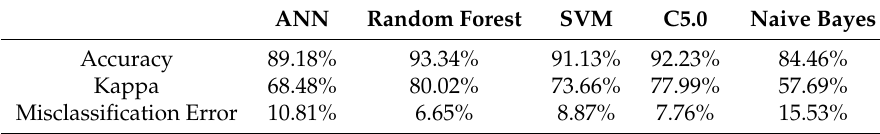
Table 4. Evaluation Criteria for CTG patient for prediction after implementing Genetic algorithm.